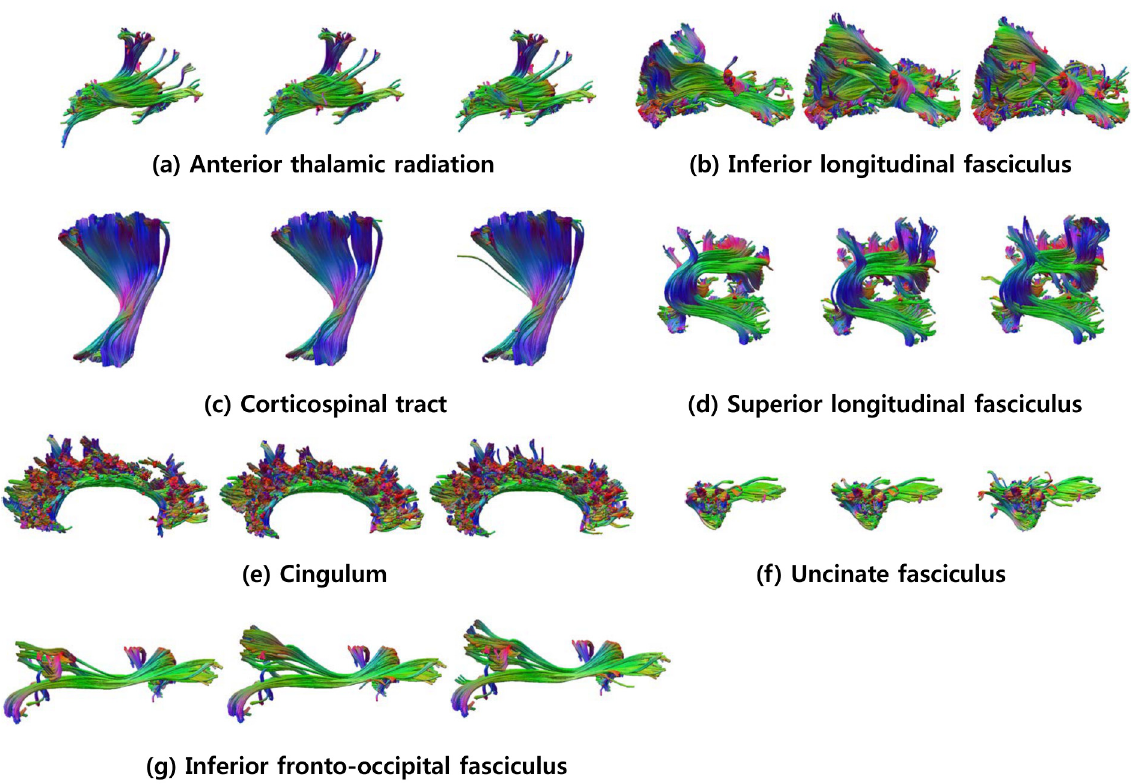
Fig 6. Comparison of expert-labeled bundles and automatically obtained bundles using our classification algorithm. The bundles in the first and fourth columns represent expert-labeled bundles, those in the second and fifth columns represent bundles obtained using tract group labeling, and those in the third and sixth columns represent bundles obtained using direct tract